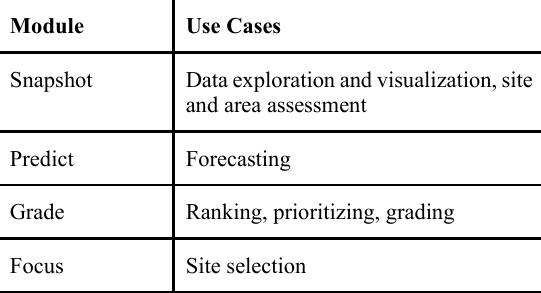
Table. 1. Module names and use cases for